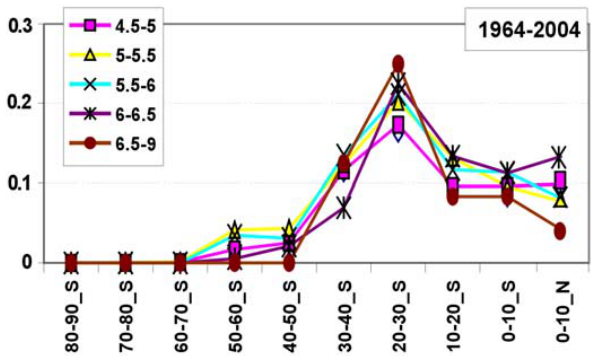
Fig. 3. Binormed latitudinal distributions of earthquakes in the Pa- Figure 3. Binormed latitudinal distributions of earthquakes in the Pacific part of the South cific part of the South America for five magnitude ranges. The hor- izontal axis is the latitudinal belts; vertical axis is binormed number America for five magnitude ranges. The horizontal axis is the latitudinal belts; vertical axis is of binormed number of earthquakes.